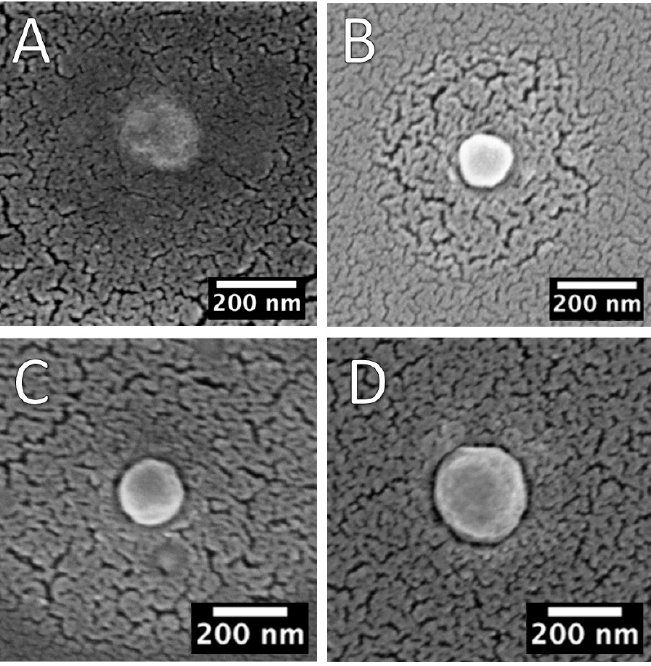
Figure 4. SEM micrographies of: ( A ) NPA ( B ) NPB-FA ( C ) NPB and ( D )